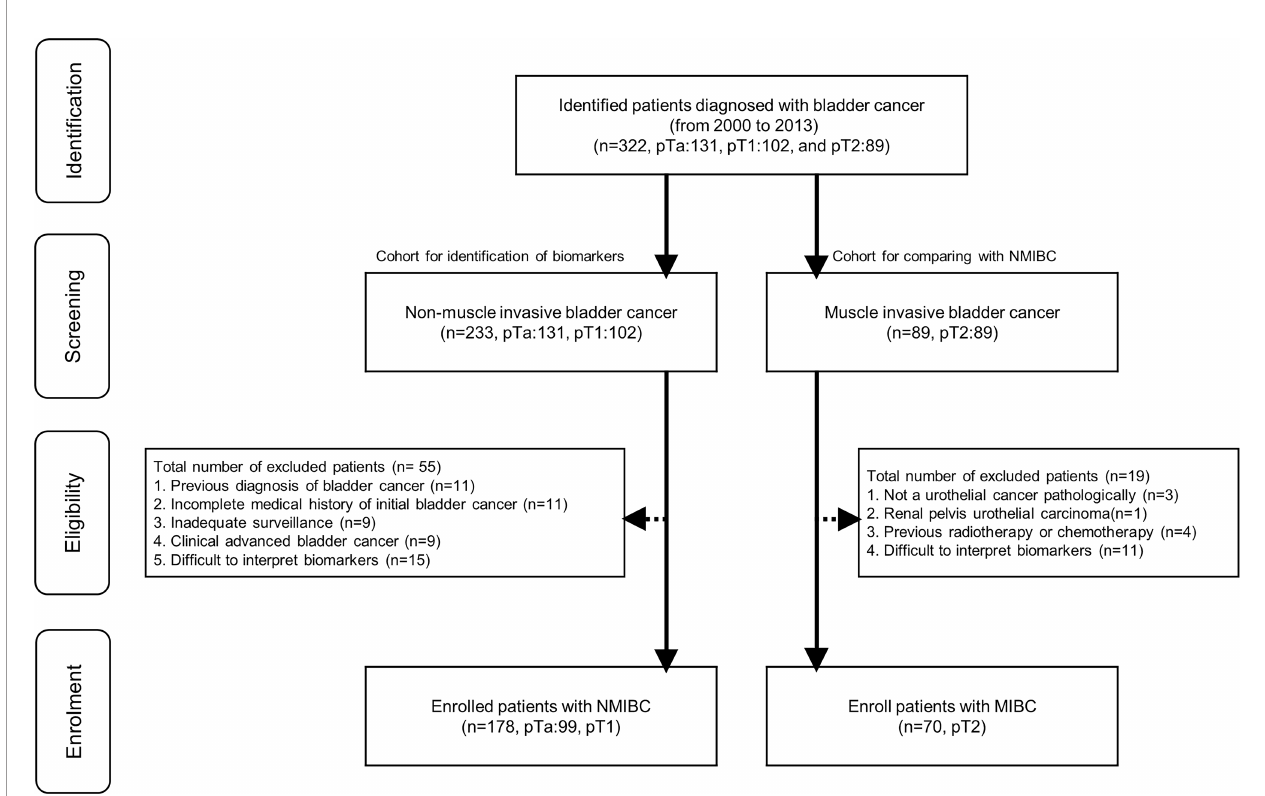
FIGURE 1 | Flowchart for enrolled patients. NMIBC, non-muscle invasive bladder cancer; MIBC, muscle invasive bladder